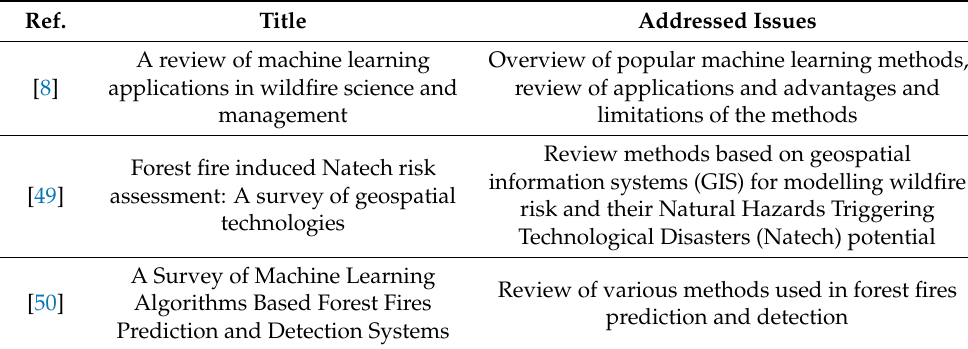
Table 1. Results: pertinent review articles and addressed issues.